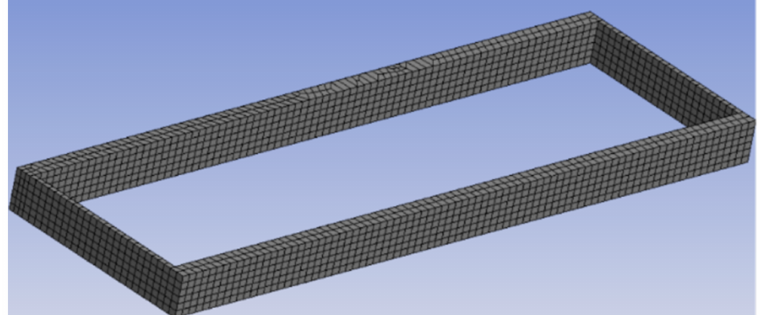
Figure 4. Panels for the ACAP.